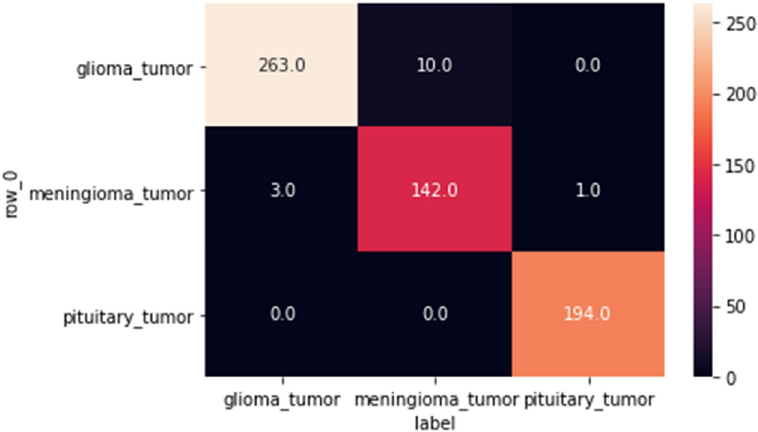
Figure 11: Confusion matrix of training dataset.